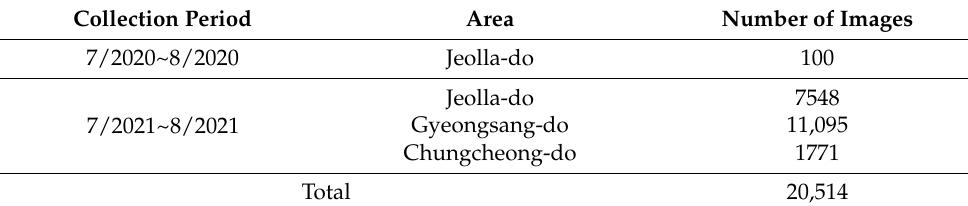
Table 3. The number of data collected for the training detection and classification model.